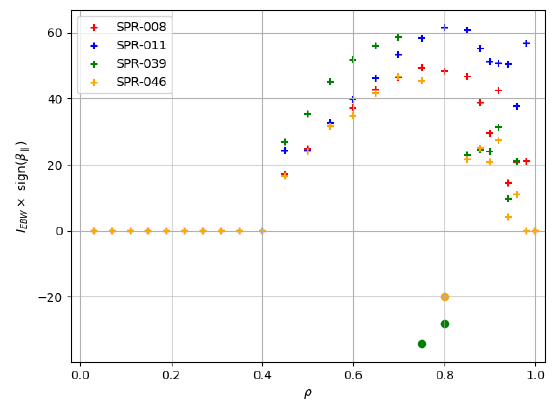
Figure 5. Total EBW driven current multiplied by the sign of the resonant electron velocity. Almost all runs show positive values implying the Okhawa effect is the dominant current drive